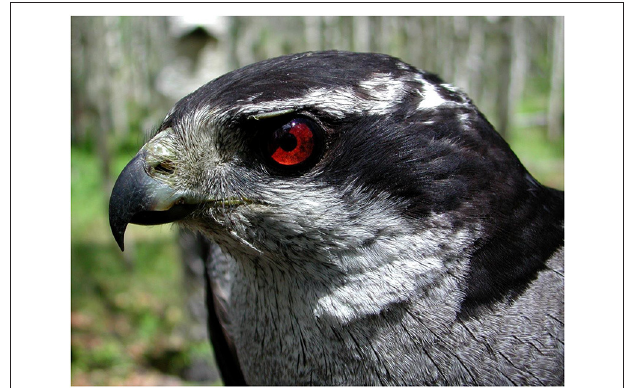
FIGURE 4 | Short term solutions: Managing goshawk habitat through forest resilience. The northern goshawk ( Accipiter gentilis ) is forest/woodland raptor with a circumpolar distribution (Squires and Kennedy, 2006). Typically associated with older, mature forests, the goshawk is a species of conservation concern throughout its North American range. Over the past century, forest-management practices have resulted in dense, fire-prone forests which lack structure needed by goshawks and are at risk of stand-replacing fire events (Reynolds et al., 1992). Conservation of goshawks requires forest physiognomy and composition to meet the life requisites of the goshawks as well as those of its primary prey species. To ensure that conditions persist through time, forests must be resilient to primary stressors—fire and climate change—that could compromise forest integrity and reduce goshawk habitat. Reynolds et al. (1992) used a synthetic approach to define the habitat needs of the goshawk in the American southwest. They assembled information on habitats of key prey species (birds, squirrels, and rabbits) and the goshawk, as well as knowledge of ponderosa pine ( Pinus ponderosa ) forest ecology. Forest ecology included composition and structure, tree longevity, disturbance factors, and landscape patterns and scale. As pieces were assembled, they converged on a forest structure that closely resembled that existing prior to European settlement of the southwest. In general terms, the structure was characterized by a matrix of groups and clumps of trees interspersed among grassy openings. Tree groups were comprised of like-sized trees representing various structural stages, from seedlings to large trees > 60cm dbh. Historical fire regimes in these